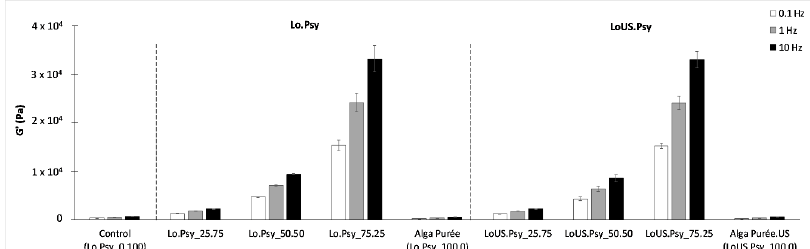
Figure 2. Elastic modulus at 0.1 Hz, 1 Hz, and 10 Hz of Laminaria-Psyllium gels with (LoUS.Psy) and without ultrasonic treatment (Lo.Psy), control, and Laminaria pur é es (Alga Pur é e; Alga Pur é e.US)